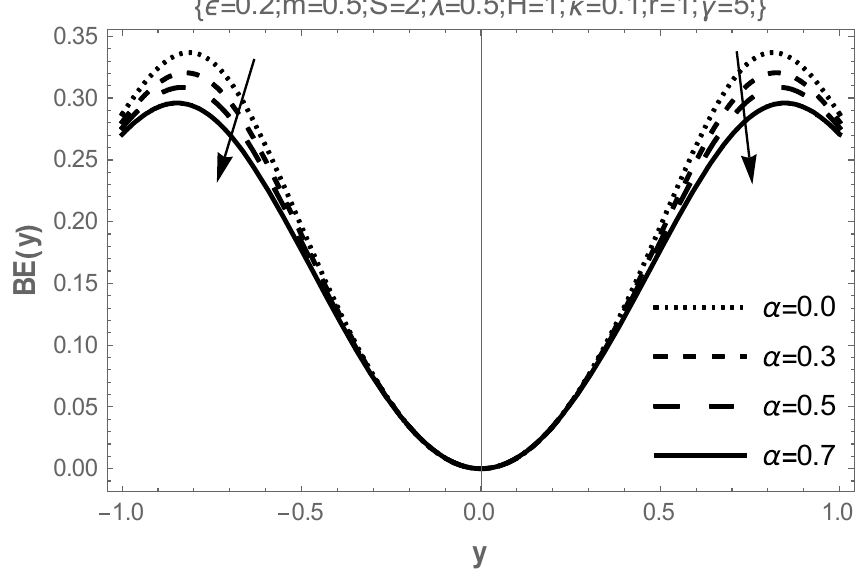
Figure 9. Effect of the porous permeability variation parameter on Bejan profile. Figure 10 shows the effect of magnetization on the flow of third-grade fluid. The velocity peak declines with increasing magnetic field strength, as seen in the plot. This decline is physically correct since the spinning of fluid particles encourages fluid thickening; therefore, flow velocity declines with the increasing intensity of the magnetic field. Similarly, the kinetic energy of the fluid particles is expected to decrease due to fluid thickening. Therefore, the liquid temperature distribution declines, as seen in Figure 11. The combined effect of reducing flow velocity and temperature shows that heat transfer and fluid friction irreversibility will uniformly decrease across the flow channel, as observed in Figure 12. The Bejan ratio signifies the dominating viscous effect over heat transfer irreversibility at the core region of the flow channel, while irreversibility from heat transfer is more at the walls as seen in Figure 13. The bifurcation study in Figure 14a,b shows the variation of the Nusselt number with the Frank–Kameneskii parameter. The reaction exponent, m , has a stabilizing effect on third-grade fluid’s thermal stability.